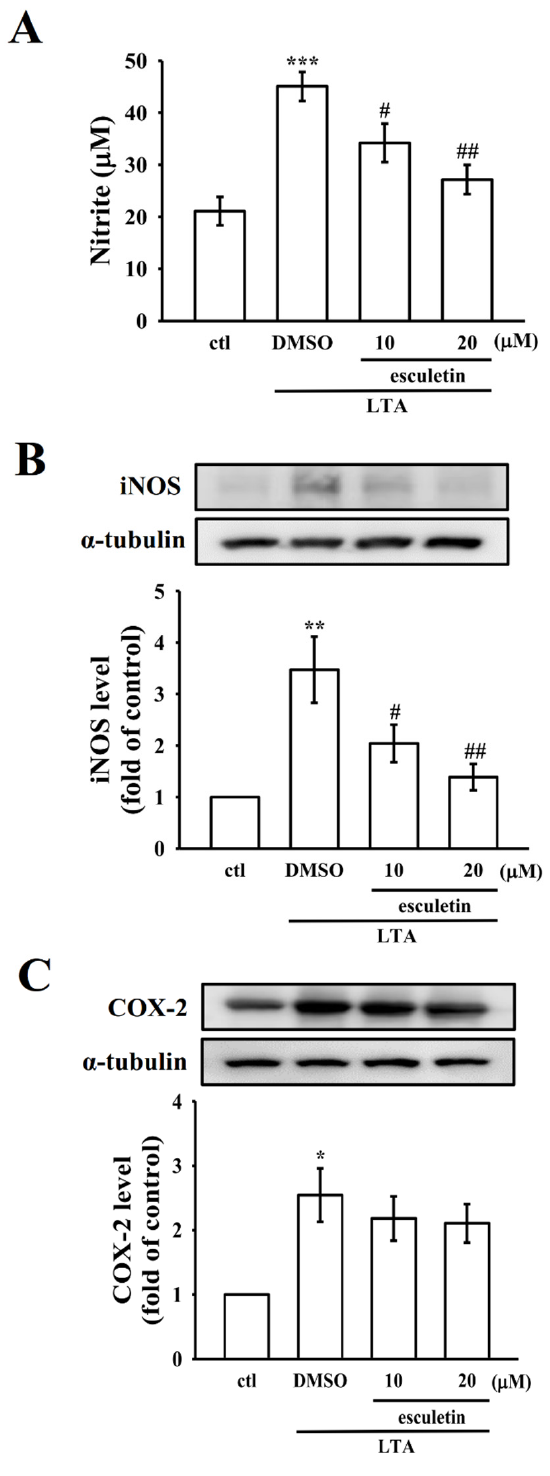
Figure 2. Effects of esculetin on nitric oxide (NO) production, and on the expression of inducible nitric oxide synthase (iNOS), and cyclooxygenase-2 (COX-2) in LTA-stimulated RAW cells. Cells were pretreated with esculetin (10 and 20 µM) for 1 h and then stimulated by LTA (10 µg/mL) for 24 h. ( A ) NO was measured using Griess reagent. ( B , C ) The levels of ( B ) iNOS and ( C ) COX-2 protein expression were evaluated as described in the Methods section. Data are presented as the means ± SEM ( n = 4); * p < 0.05, ** p < 0.01, and *** p < 0.001, compared with the control group; # p < 0.05 and ## p < 0.01, compared with the LTA group.